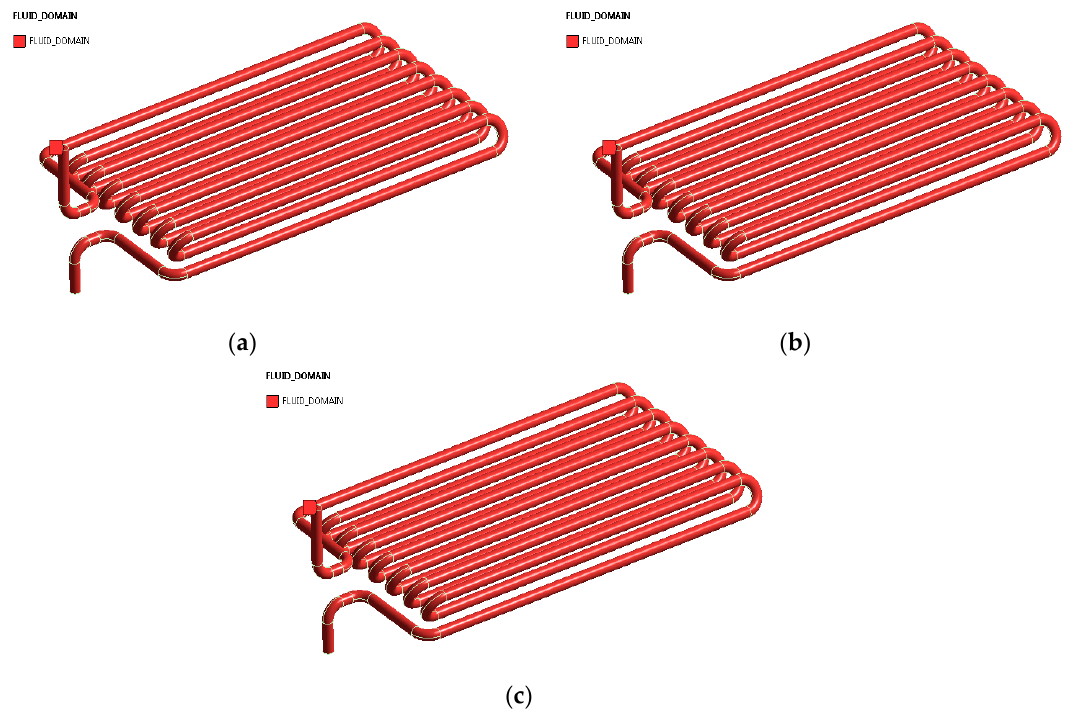
Figure 8. ( a ) 50 µm, ( b ) 80 µm, ( c ) 100 µm copper coating on Aluminium Radiator tubes.